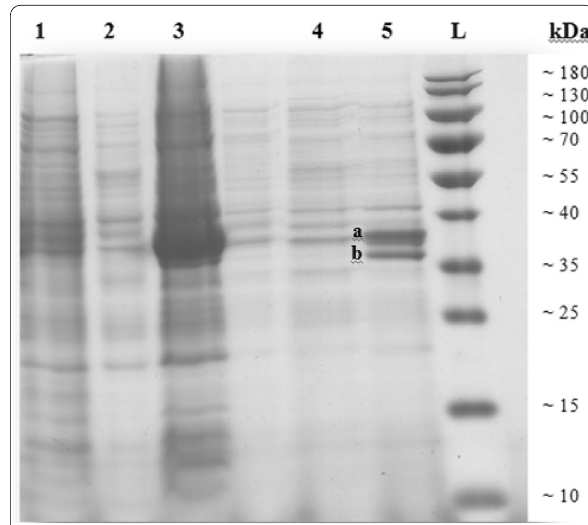
Fig. 1 SDS-PAGE of UC chimaera expressed in E. coli with 1 mM IPTG and overnight incubation at 20 °C. Soluble (1) and insoluble (2) fractions before IPTG induction and soluble (3) and insoluble (4) fractions after induction were resolved on SDS-PAGE. Lane 5 is a dilution of lane 3. The positions of intein–caleosin (~ 40 kDa) and uricase (~ 34 kDa) were indicated by a and b, respectively